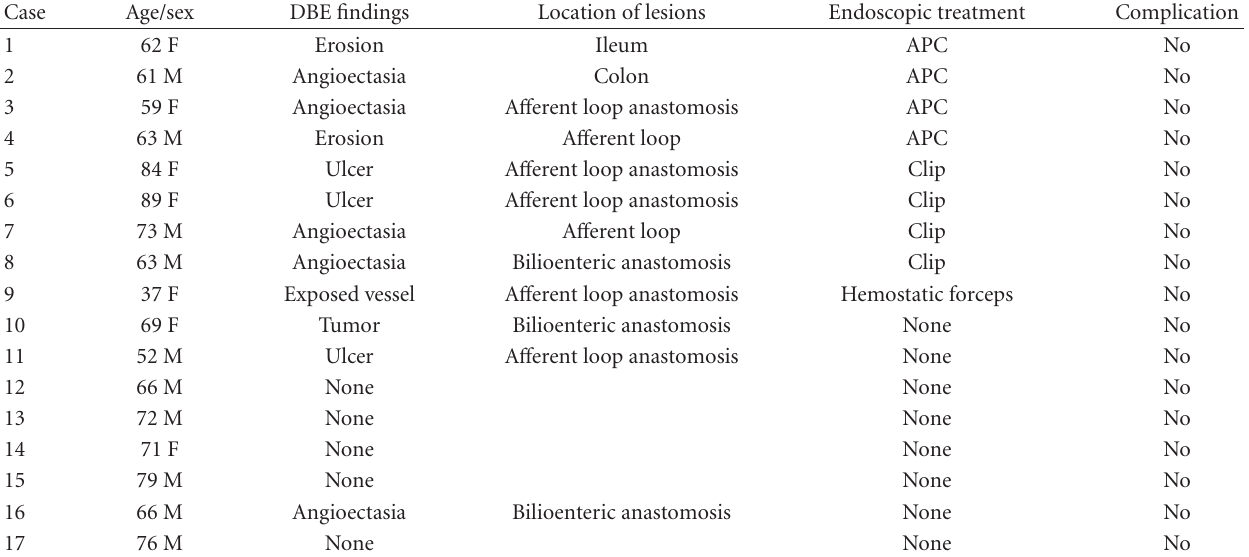
Table 2: Summary of the cases and results of